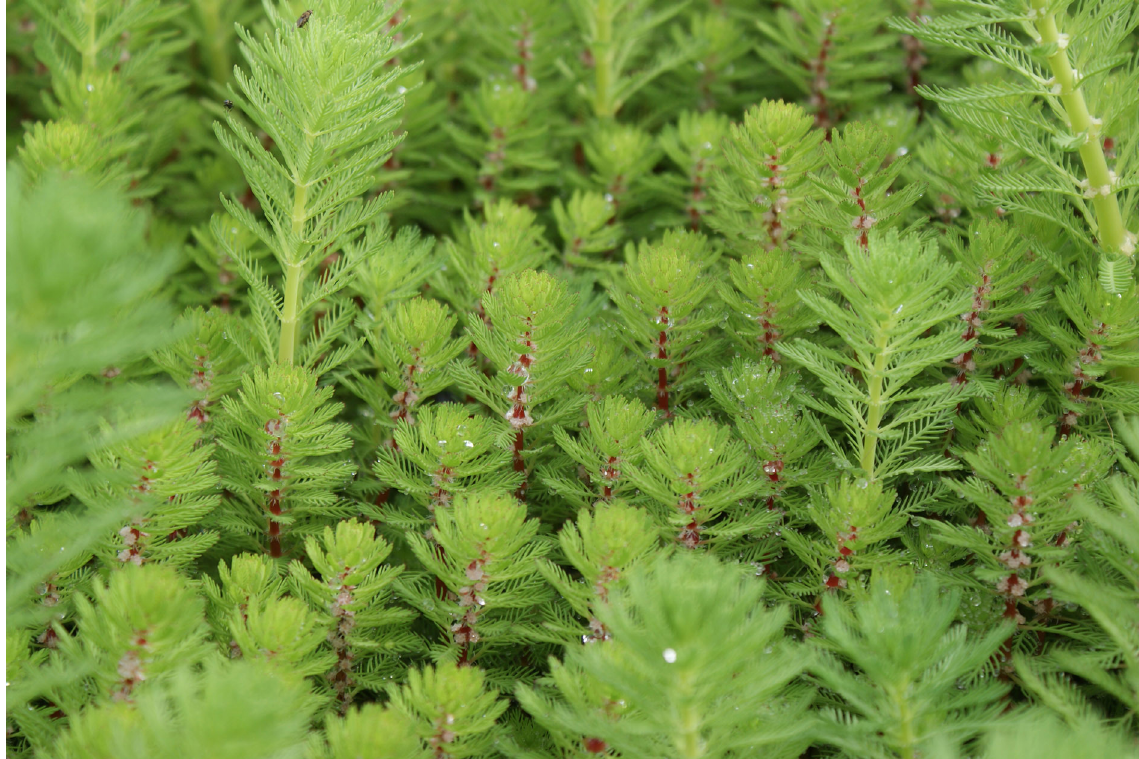
Fig. 1. Plants, prior to collection, of M. rubricaule Valk. & Duist. sp. nov. ( Valkenburg 3495 ; red stem) growing amidst M. aquaticum ( Valkenburg 3494 ; green stem) in an artificial pond at a golf course, illustrating the more modest dimensions and color differences (13 July 2009, Grashoek, the